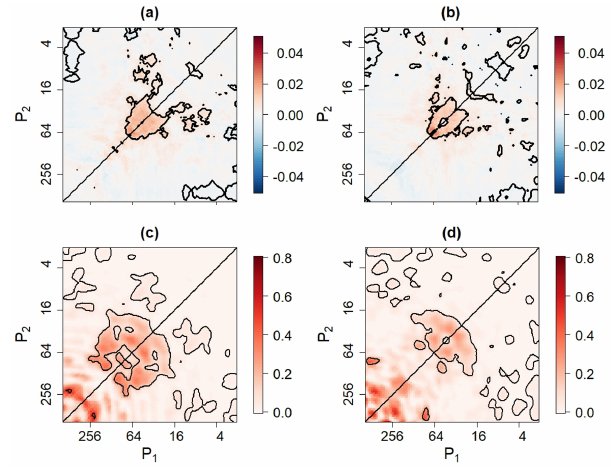
Figure 8. The waveform skewness spectra corresponding to the (a) Niño 1 + 2 and (b) Niño 3 indices. The corresponding auto- bicoherence spectra of the (c) Niño 1 + 2 and (d) Niño 3 indices. Contours enclose regions of 5% statistical significance.